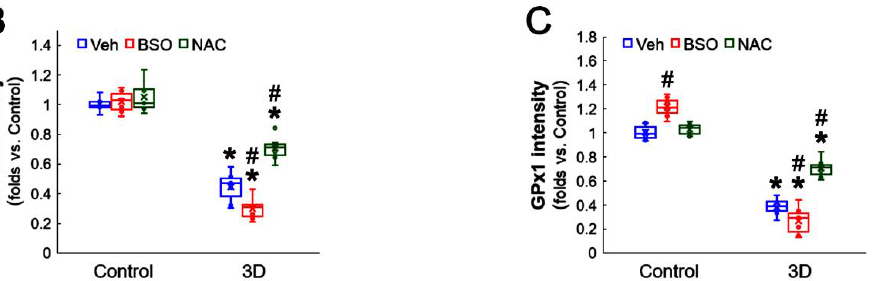
Figure 3. Effects of BSO and NAC on GPx1 expression in CA1 neurons under physiological- and 3 day-post-SE conditions. Under physiological conditions, BSO increases GPx1 expression, while NAC does not affect it, as compared to vehicle (Veh). Three days after SE, BSO aggravates SE-induced CA1 neuronal death accompanied by the reduced GPx1 expression. NAC attenuates SE-induced CA1 neuronal loss and decreased GPx1 expression. ( A ) Representative photos of GPx1 expression and its intensity. Bar = 25 µ m. ( B , C ) Quantification of NeuN ( B ) and GPx1 ( C ) intensity in CA1 neurons ( C ) (*, # p < 0.05 vs. control and vehicle, n = 7, respectively).